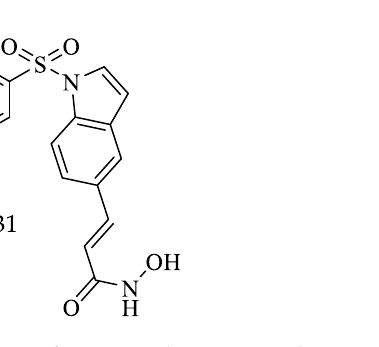
Figure 5. Structure of compound MC3031 with epigenetic effects against T. brucei .